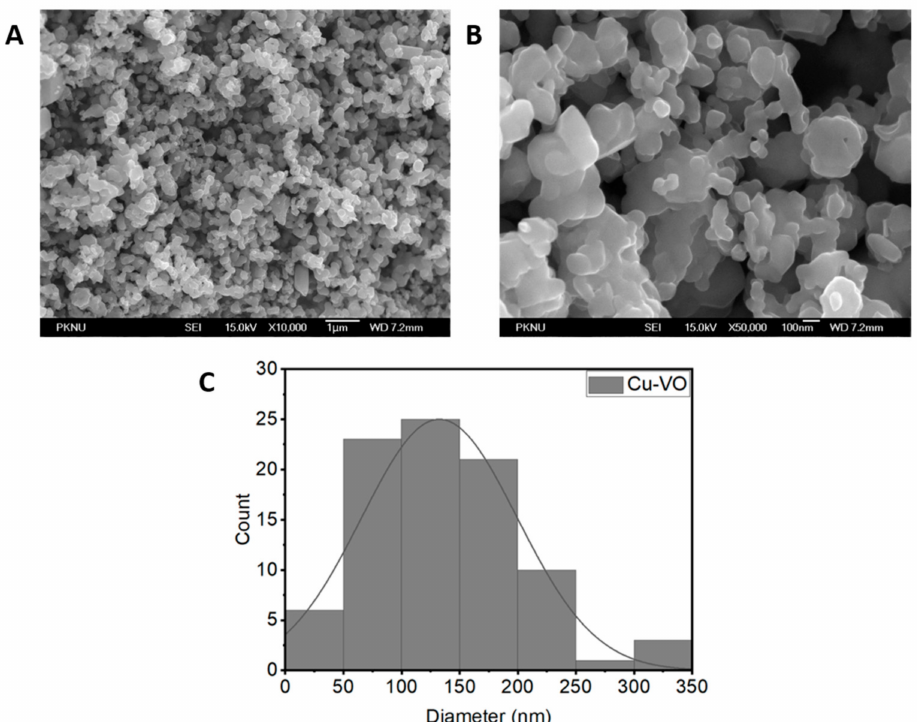
Figure 1. FESEM image of Cu-VO: ( A ) low magnification, ( B ) high magnification, and ( C ) particle size distribution. The particle size distribution plot of Cu-VO was obtained using a high-magnification FESEM image ( B ).